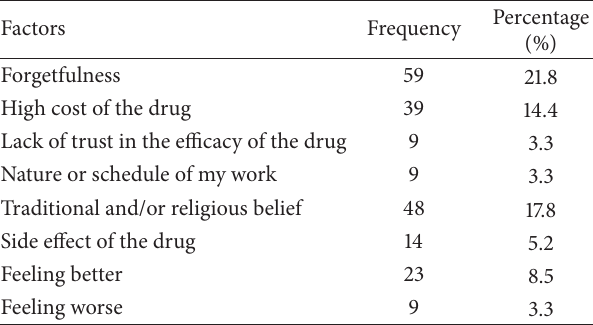
Table 2: Patients’ opinions on factors that prevent optimal medica- tion adherence, Adama, Ethiopia,